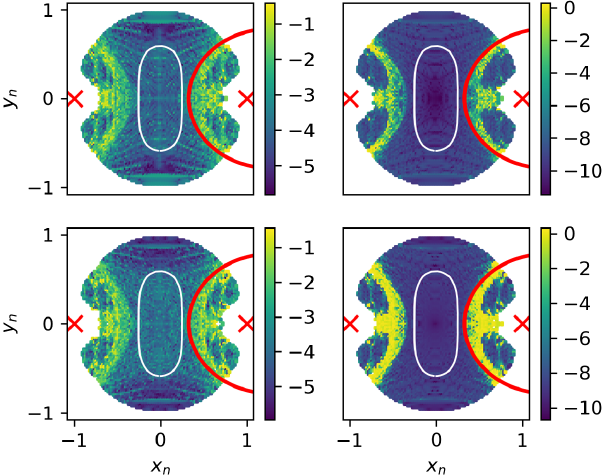
FIG. 18. Comparison of FMA (left) and REM (right) for a realistic IOTA lattice with 2D symplectic space-charge. The time interval is T ¼ 128 (top) and T ¼ 256 (bottom). The white contour corresponds to the boundary of the initial waterbag beam Eq. (15).